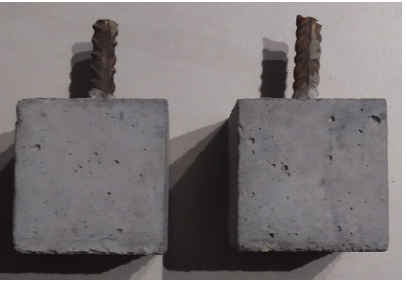
Figure 1. Reinforced concrete cubes for experimental procedure .